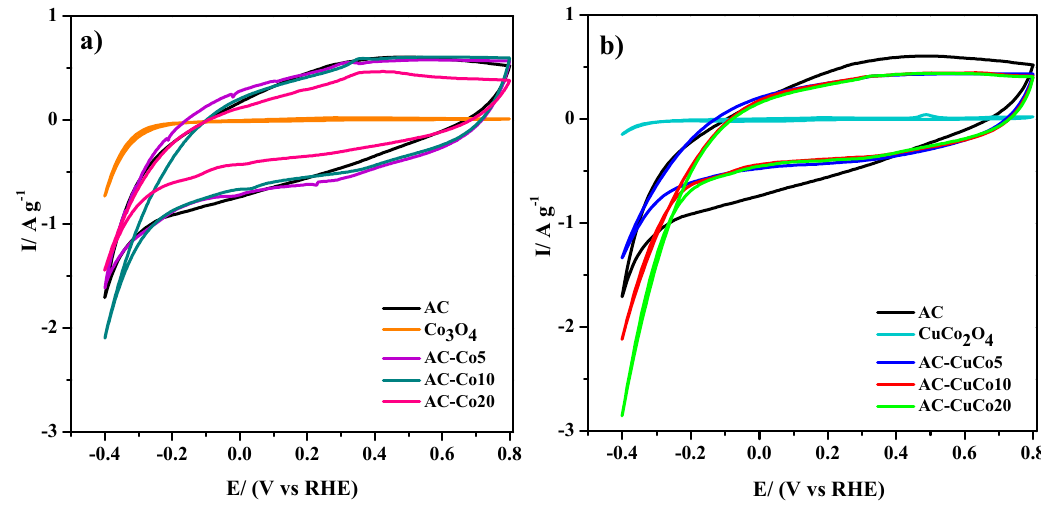
Figure 4 . Cyclic voltammograms recorded in 0.1 M KOH showing the hydrogen evolution reaction at ( a ) undoped AC-Cox samples and ( b ) copper-doped AC-CuCox. Scan rate: 2 mV s − 1.